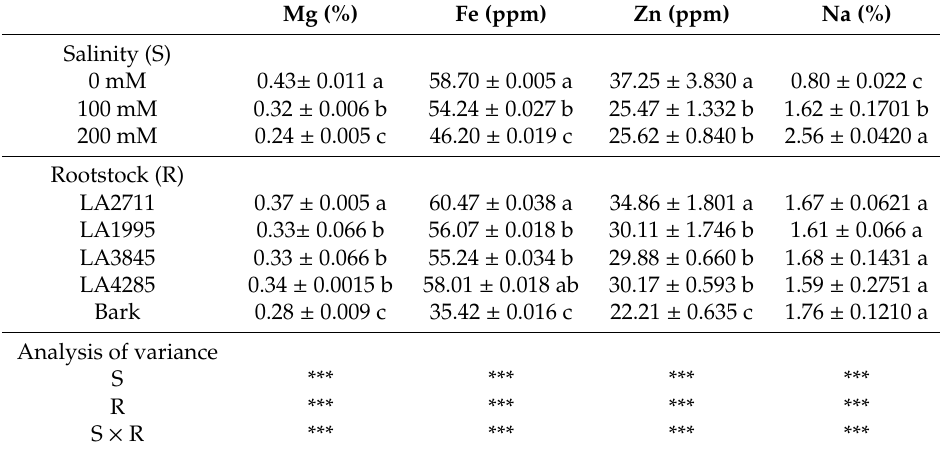
Table 10. Effect of salinity treatments, rootstocks and their interactions on the minerals of the tomato shoots.